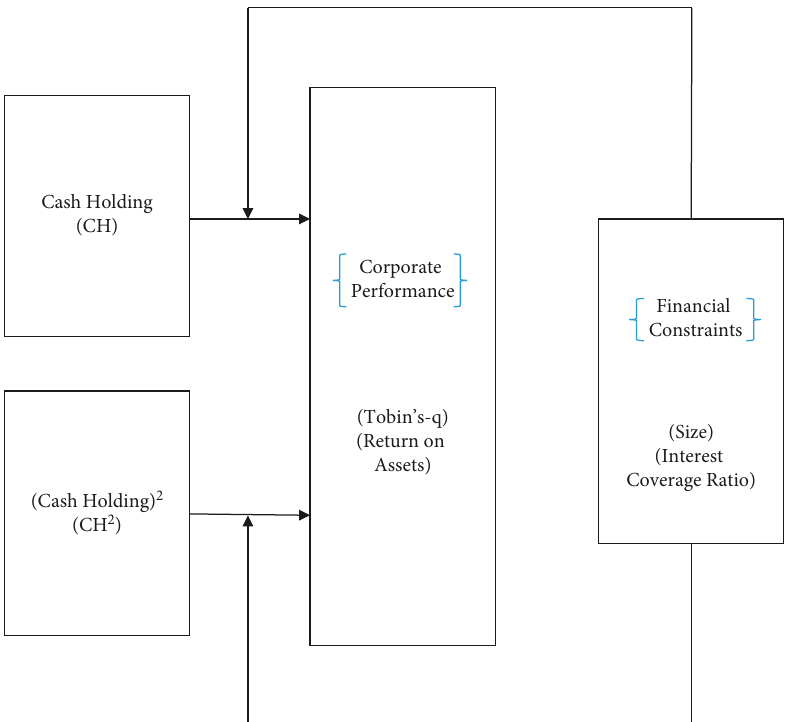
Figure 1: Impact of optimal level of cash holdings on corporate performance with the influence of financial constraints as moderating